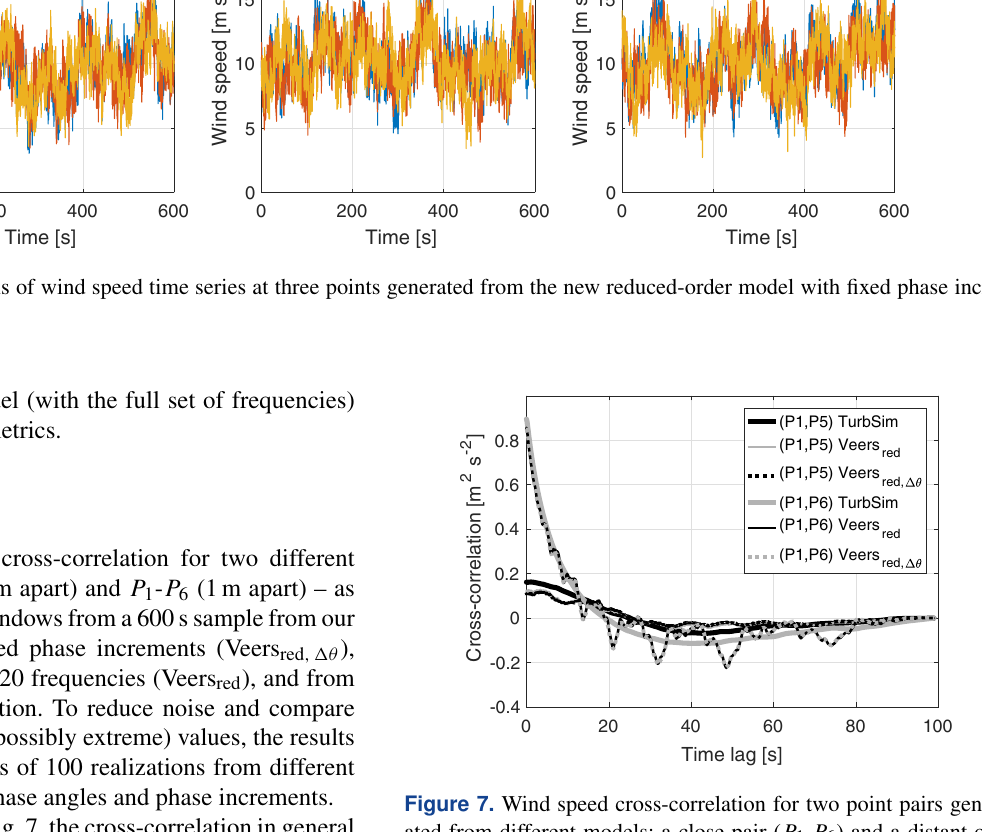
(not included in Fig. 7), shows that for all three models the cross-correlation is almost identical to the curve for P 1 – P 6